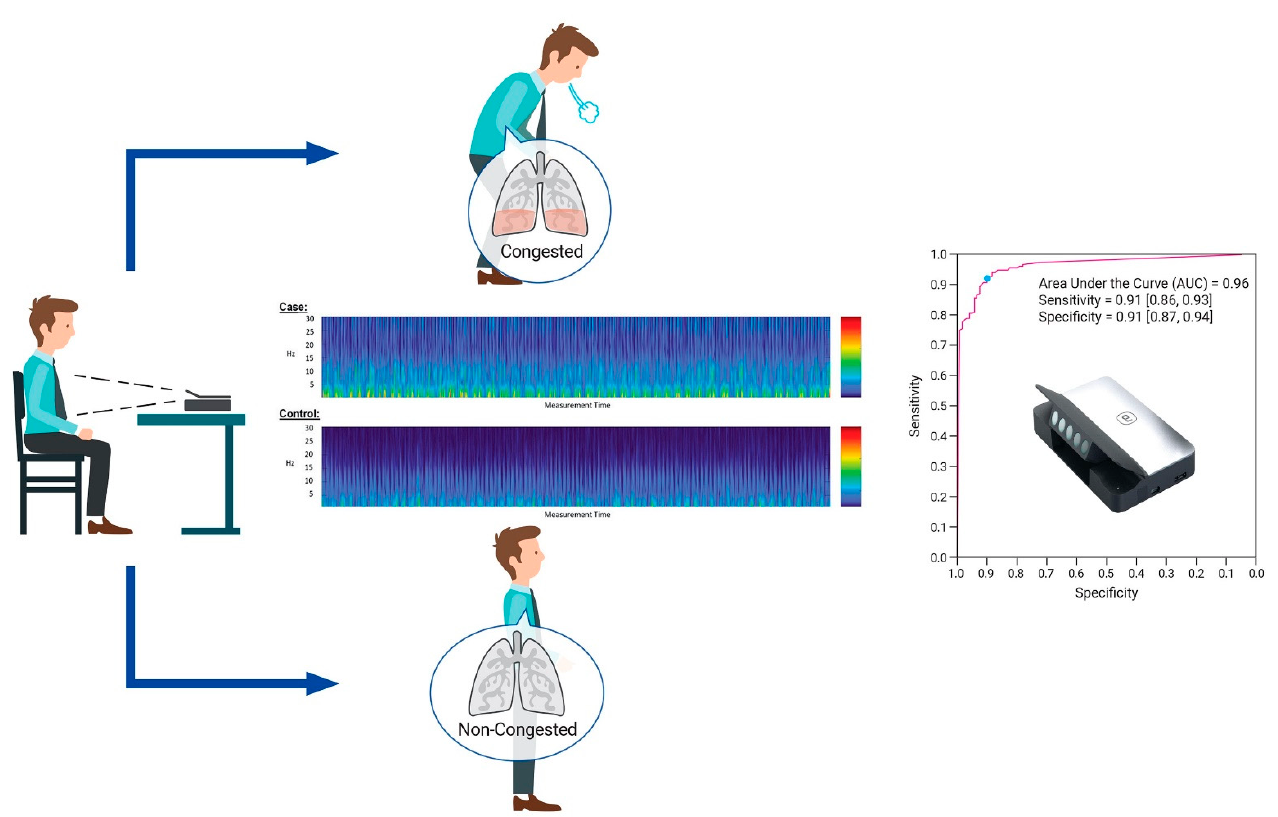
Figure 7. A contact-free optical device for the detection of pulmonary congestion.